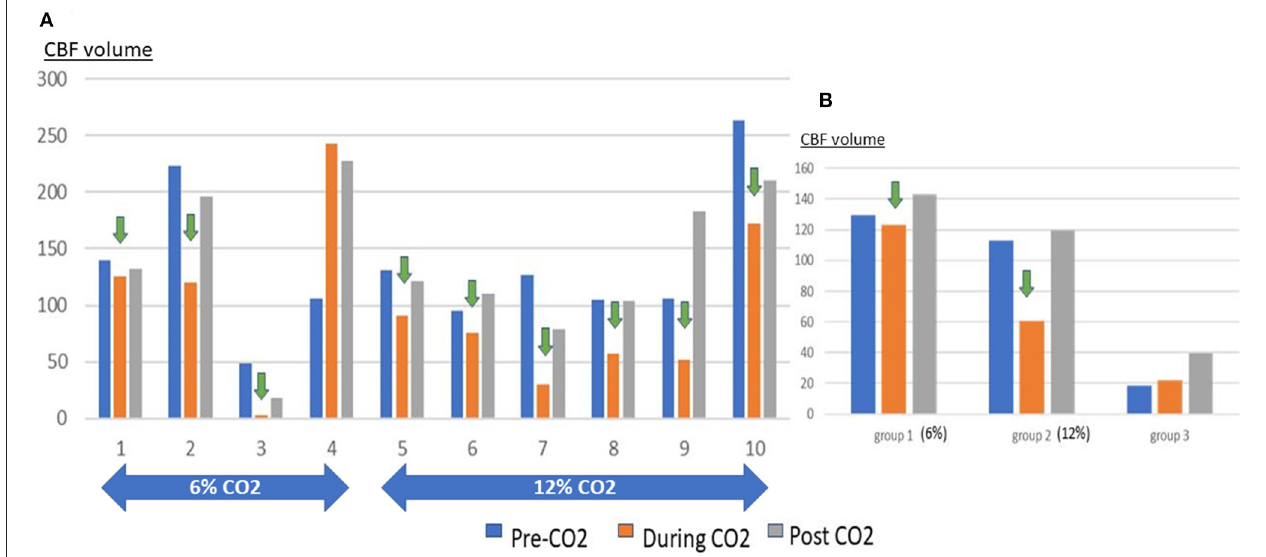
FIGURE 1 | Graphs showing the volume of CBF hypoperfusion at pre-CO 2 , CO 2 administration and post-CO 2 time points. (A) shows the individual rats, Note the reduction of CBF hypoperfusion with CO 2 administration and rebound when it is stopped. (B) shows the results in group 1 (6% CO 2 ), group 2 (12% CO 2 ) and group 3 (Control). Note the increased CBF hypoperfusion with 12% CO 2 compared to 6% CO 2